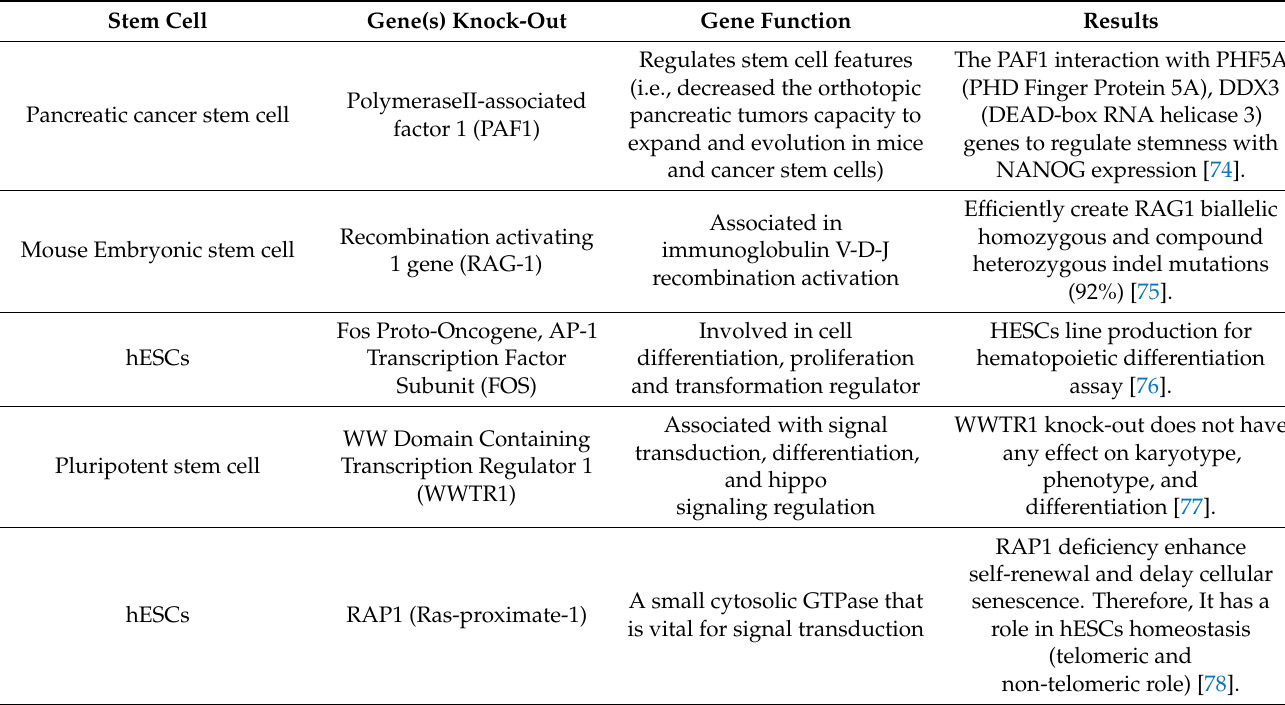
Table 1. Application of CRISPR knock-out system in studying the function of stem cell genes (all of the knock-outs done by CRISPR-Cas9